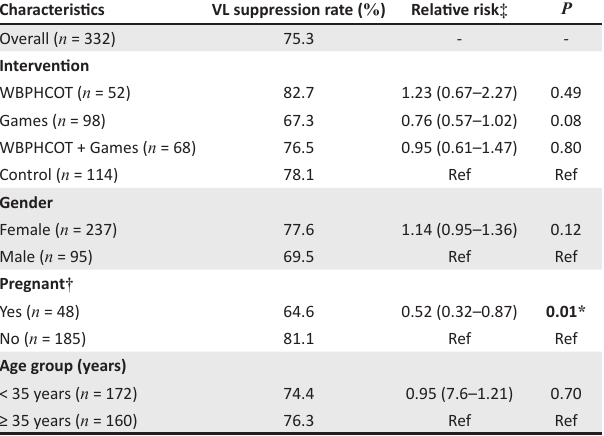
TABLE 4: Virological suppression. Characteristics